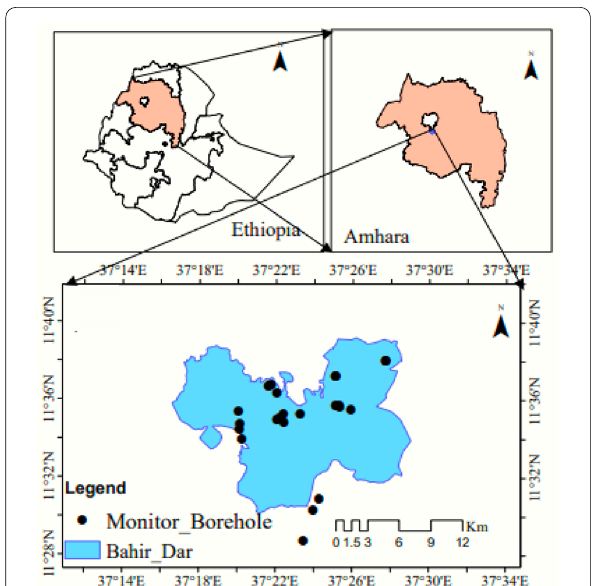
Fig. 1 Location of Bahir Dar City, capital of Amhara Regional State in